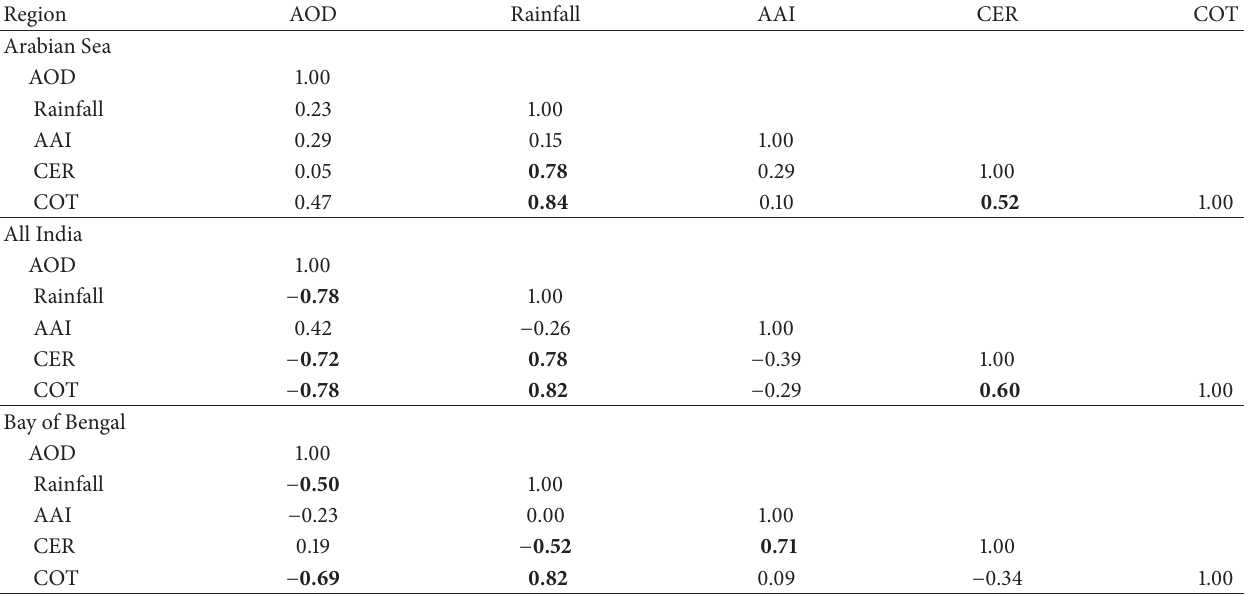
Table 3: Correlation coefficient between aerosol optical depth (AOD), rainfall, absorbing aerosol index (AAI), cloud effective radius (CER), and cloud optical thickness (COT) over the Arabian Sea, all India, and the Bay of Bengal during the summer monsoon (JJAS) between 2001 and 2010. Correlation coefficient ( 𝑅 2 ) values ≥ 0.5 are highlighted in bold. Region AOD Rainfall AAI CER COT Arabian Sea 1.00